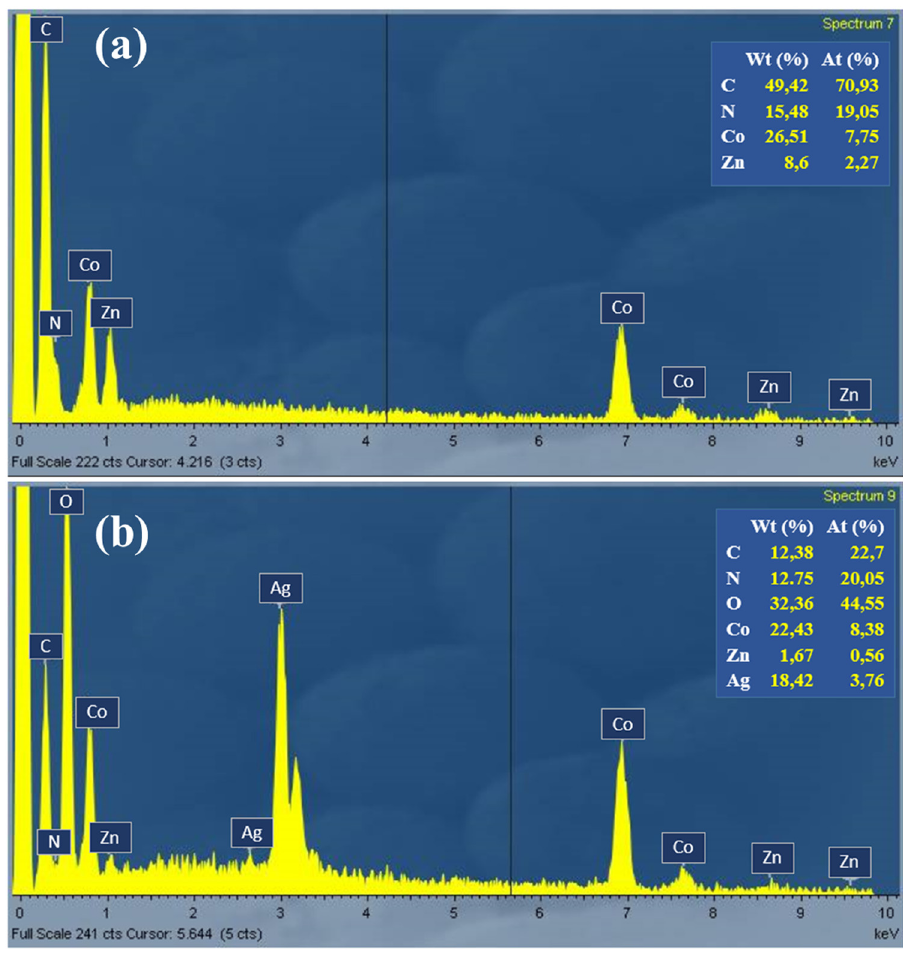
Figure A4: FT - IR spectra of 2 - MIm, ZnCo - ZIFs, and Ag/ZnCo - ZIFs.